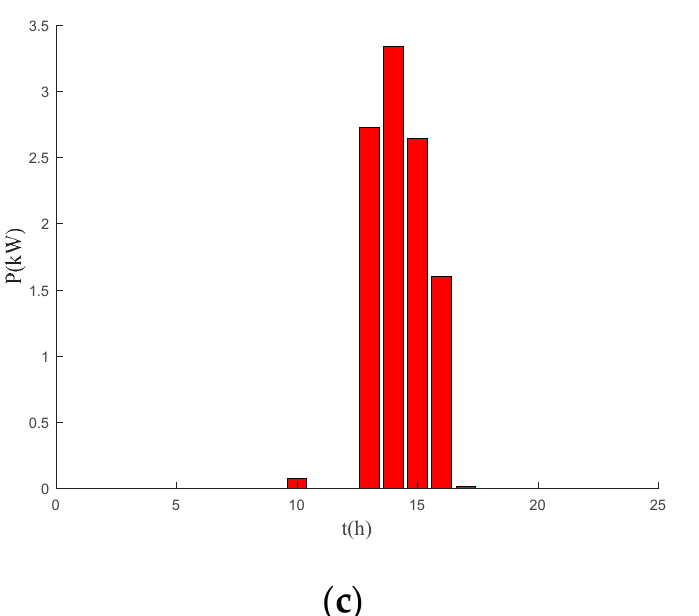
Figure 15. Scheduling results of new microgrid scenarios. ( a ) Scheduling results of winter. ( b ) Scheduling results of summer. ( c ) PV curtailment of microgrid in summer.